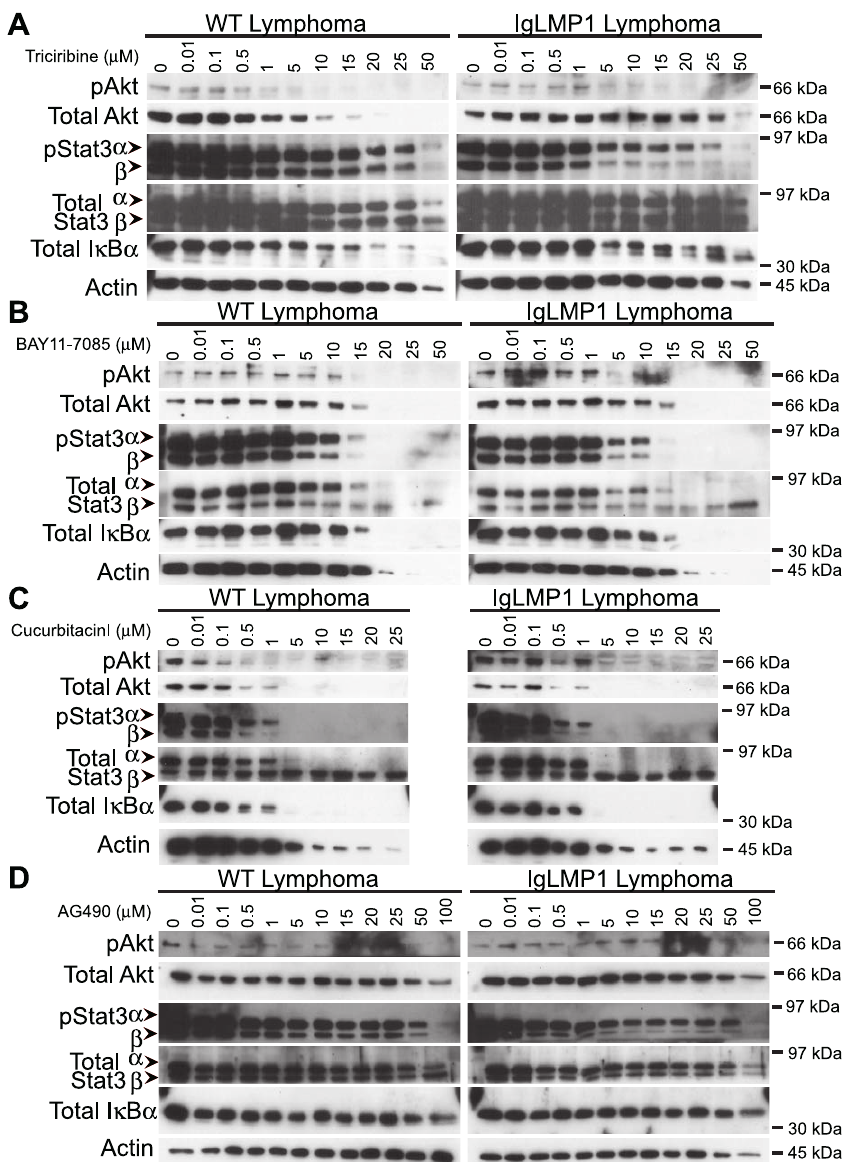
Figure 8. Analysis of Akt, NF j B, and Stat3 Pathways in Contribution to the Growth and Survival of Lymphoma Cells (A–D) Immunoblot analysis of wild-type and LMP1 transgenic lymphomas for Akt, NF j B, and Stat3 signaling after treatment with (A) an Akt inhibitor, triciribine, (B) an NF j B inhibitor, BAY11–7085, and the Stat3 inhibitors (C) cucurbitacin I and (D) AG490, at the indicated concentrations. Arrows indicate the positions of a and b isoforms of Stat3. Actin was used as a loading control.